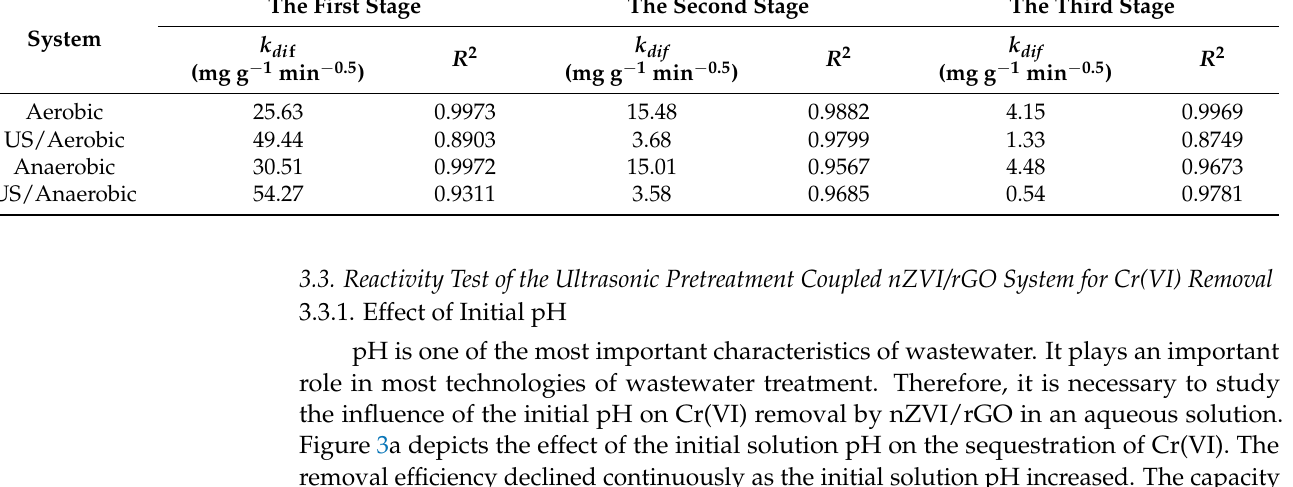
Table 4. Parameters of the intraparticle diffusion models in different systems.